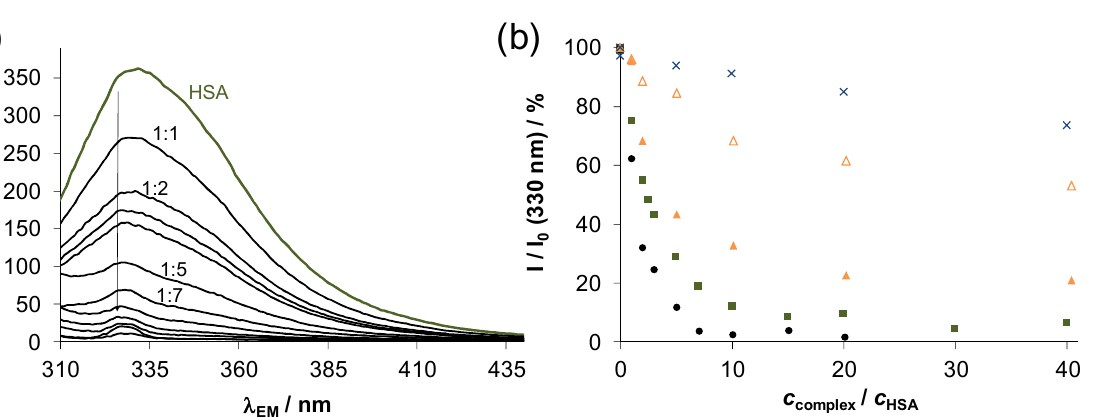
Figure 8. ( a ) Fluorescence emission spectra obtained for HSA titrated by complex 1 using λ EX = 295 nm. ( b ) Intensity changes (%) at 330 nm at the various HSA-to-complex ratios for complex 1 ( ■ ), complex 2 (×), complex 3 (●) complex 4 (∆; ▲ (batch samples using 48 h equilibration time)). { T = 25.0 °C, pH = 7.40 PBS’ buffer, c HSA = 1 μM}. Table 5. Conditional binding constants of the compounds at binding sites I and II of HSA deter- mined by spectrofluorometric Trp-214 quenching (log K Q ’) and site marker (WF or DG) displacement (log K WF ’ and log K DG ’) measurements. {pH = 7.40 PBS’ buffer; T = 25 ◦